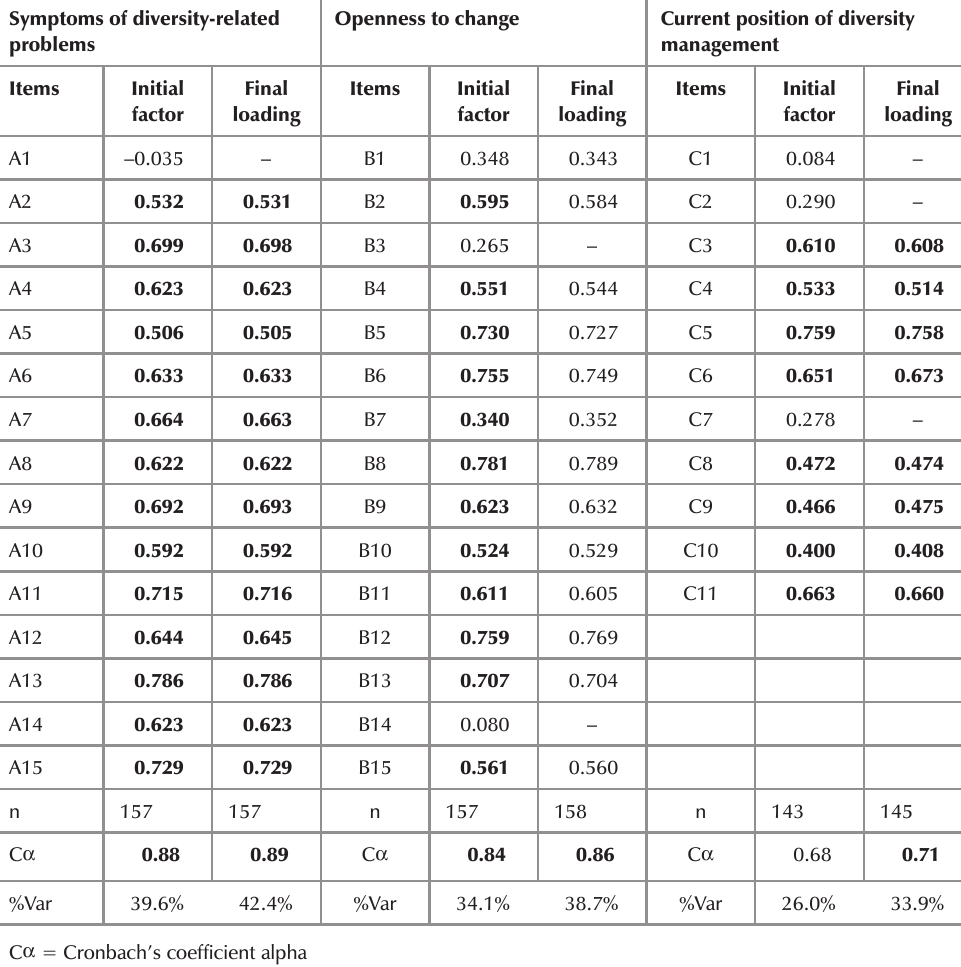
% Var = Percentage variation explained by factor